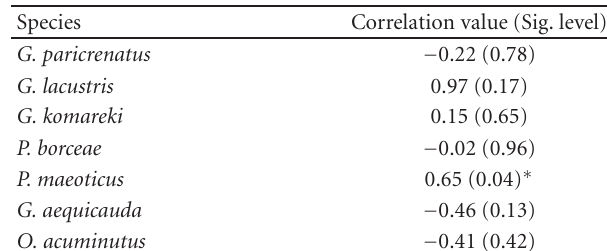
Table 3: Pearson correlation of mean egg number with percentage of ovigerous females during di ff erent months for each